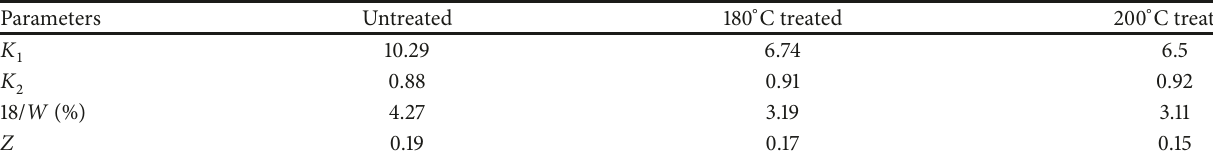
Table 2: Values for parameters in Hailwood-Horrobin sorption theory and moisture sorption coefficient Z .